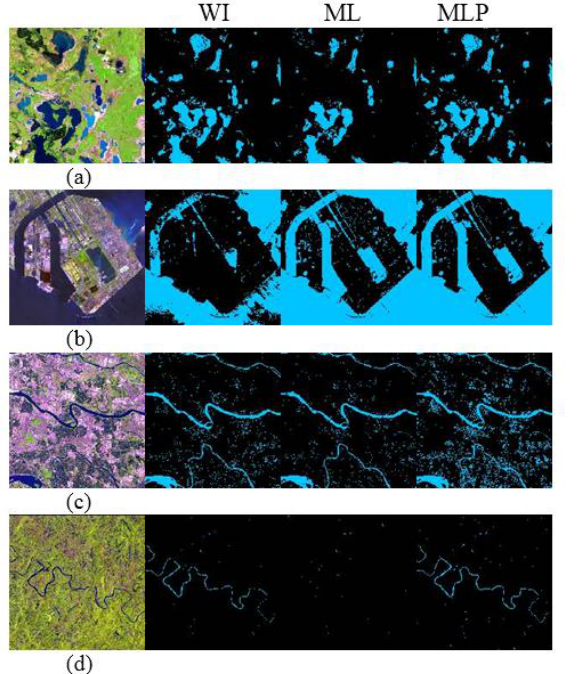
Figure3 The typical water bodies of Landsat8